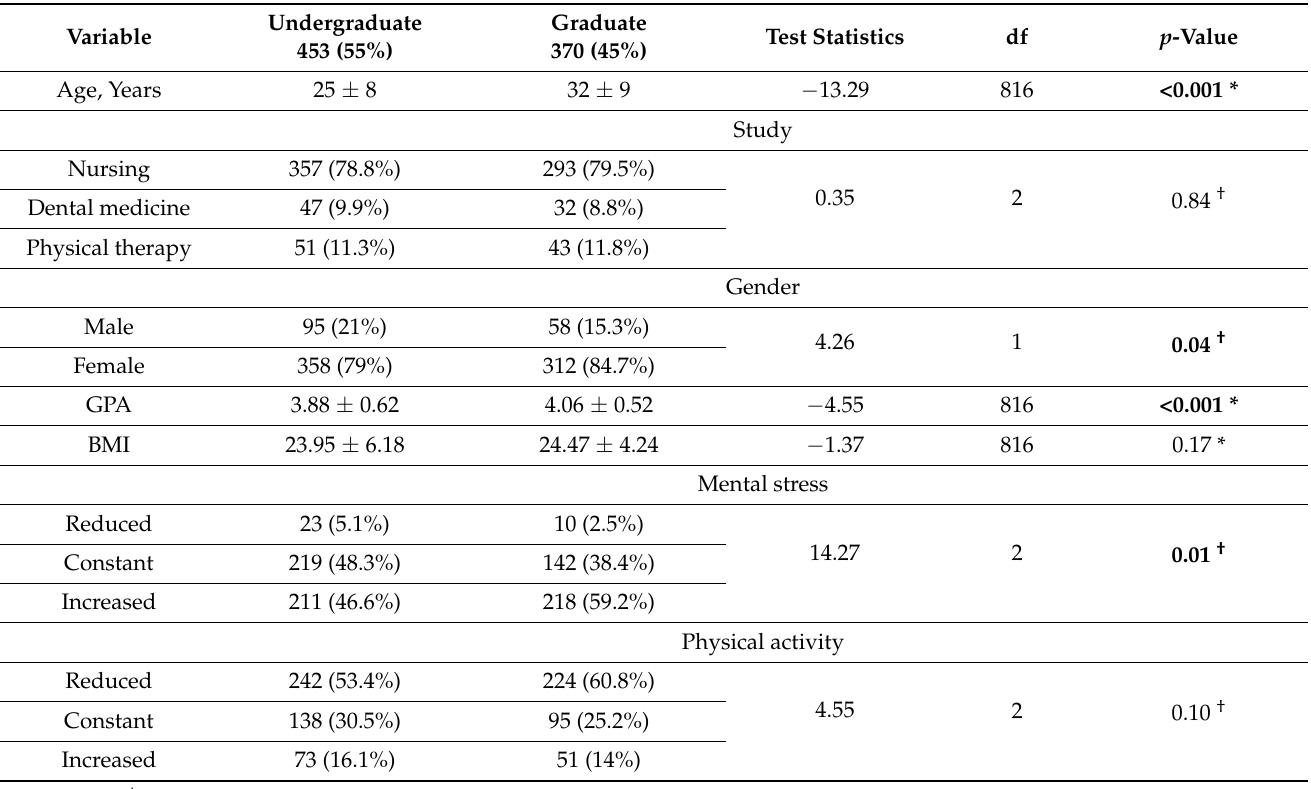
Table 8. Socio-demographic data and self-assessment of mental stress and physical activity according to the study program. Variable